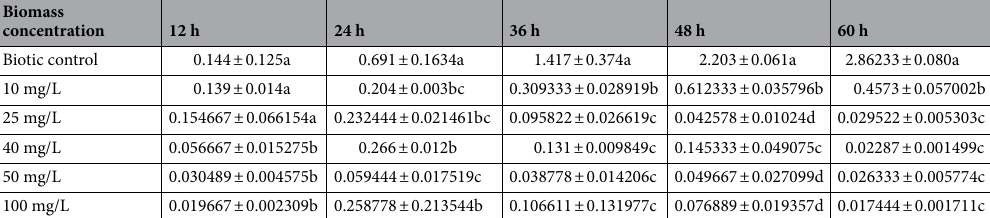
Table 2. One way ANOVA analysis. All values are represented as mean ± SD. Different alphabets represents difference in mean according to one way ANOVA followed by Duncan’s post hoc test at probability level (p ≤ 0.05).